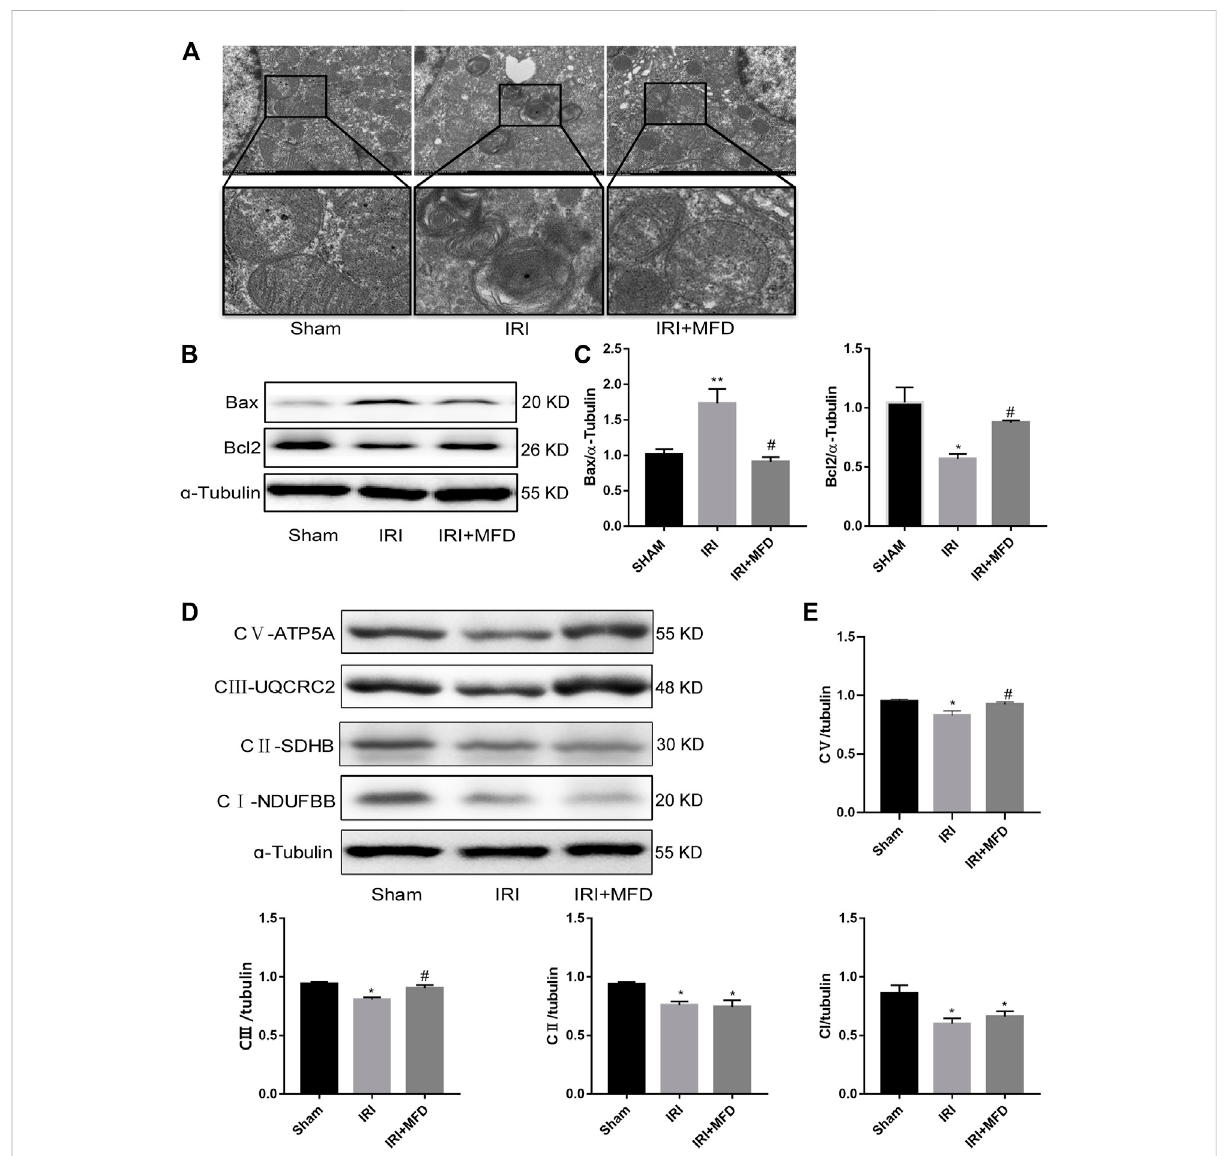
Mefunidone protected IRI-induced mitochondrial damage and complex Ⅲ and Ⅴ of mitochondrial electron transport chain complex (A) Electron microscope analysis of mitochondria in the renal tissues on day 2 after IRI modeling (×8,000). (B,C) Western blot analysis and quantitative data of bax and bcl2 in the renal tissues on day 2 after IRI modeling. (D,E) Western blot analysis and quantitative data of mitochondrial electron transport chaincomplexintherenaltissueson day2after IRImodeling.Mefunidone:100 mg/kg.Data representmean± SEM(n=3).* p < 0.05, vs . Sham group; ** p < 0.01, vs . Sham group; # p < 0.05, vs. IRI